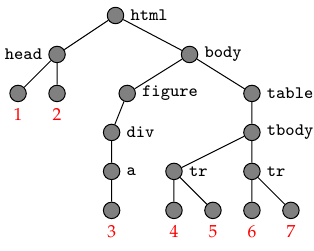
Figure A1. An ordered